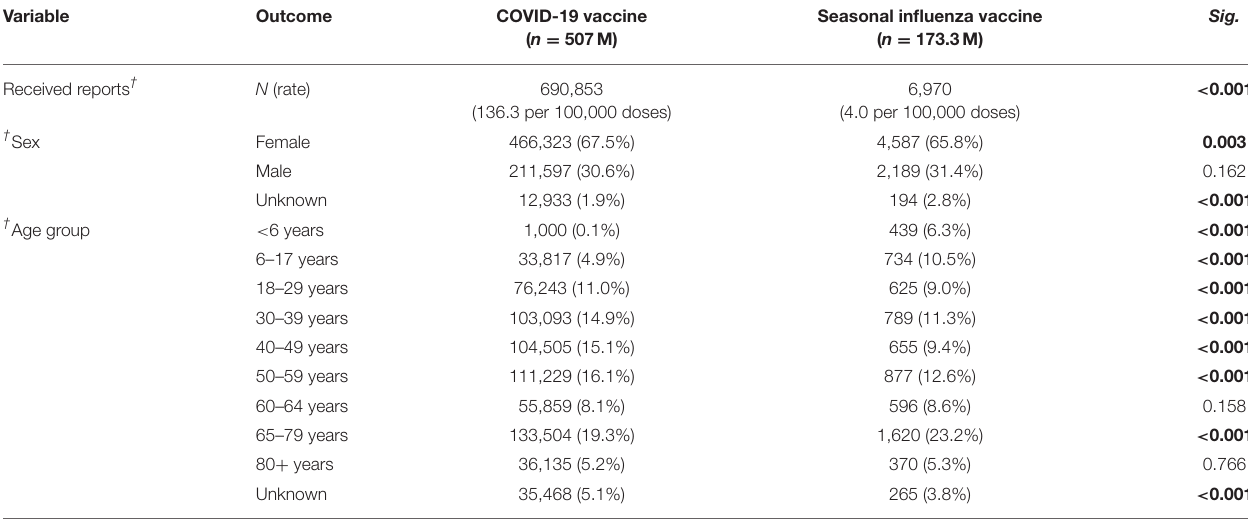
TABLE 1 | Demographic characteristics of COVID-19 and seasonal influenza vaccines recipients in the United States, January–December 2021 (CDC; VAERS-WONDER).